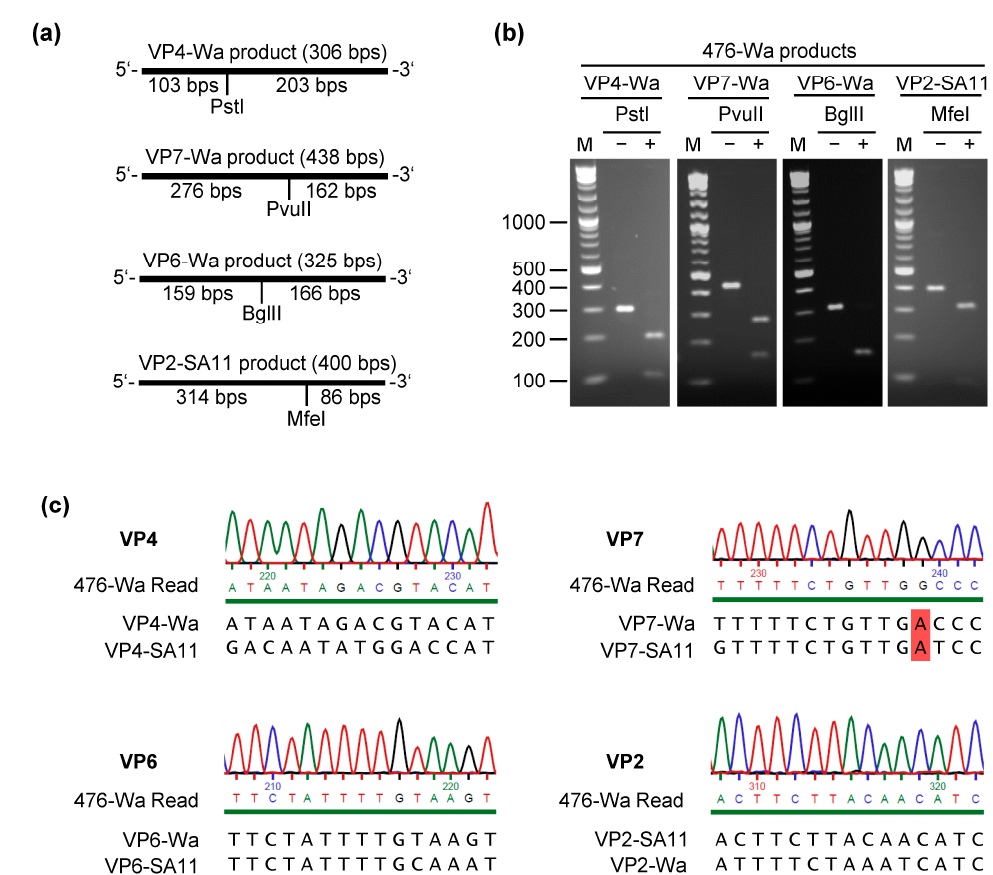
Figure 2. Analyses of RT-PCR products of the VP4/VP7/VP6-Wa triple-reassortant (476-Wa). ( a ) Expected size and position of restriction sites. Bps = base pairs. ( b ) Agarose gel analyses of restriction digests. The numbers indicate the size of the DNA marker fragments (M) in bps. ( c ) Sanger sequencing results. Examples of the chromatograms from the 476-Wa sequencing read are shown. The corresponding Wa and SA11 nucleotide sequences are depicted below each chromatogram. The position at which VP7 from 476-Wa differs from both VP7-Wa and VP7-SA11 is highlighted in red. The green line below the chromatograms indicates that the probability for a wrong base call was equal to or less than 1 in 1000.